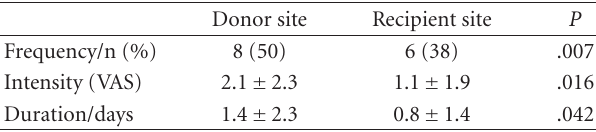
Table 2: Postsurgical pain.